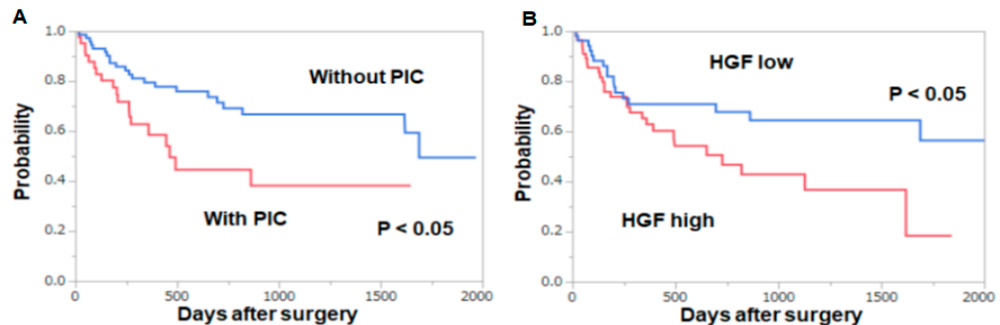
Figure 2. Overall survival after esophagectomy. ( A ) Comparison between the patients with and without PICs ( B ) Comparison between the patients whose HGF levels on POD 3 were three times or more higher than the preoperative values and of those less than three times higher. Survival rates were calculated using the Kaplan–Meier method, and the significance of the difference in survival rates was determined using the log-rank test.